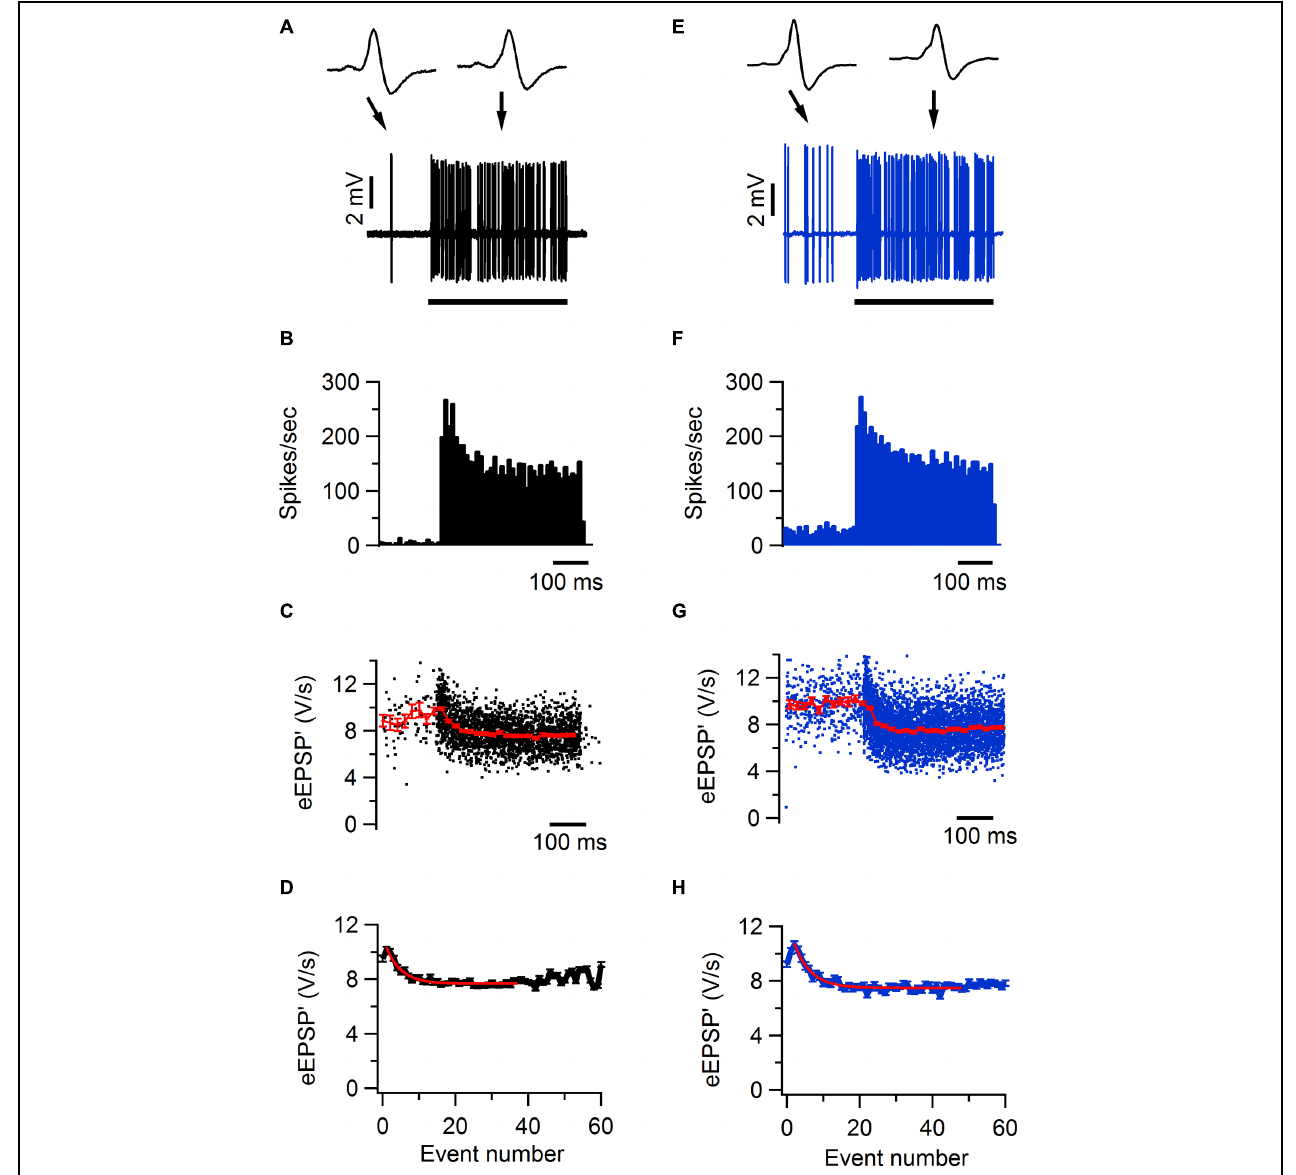
FIGURE 4 | Sound-evoked STD in Tsc1 + / − and wild-type mouse. (A) Increase in firing frequency during a 400 ms, 80 dB noise burst in a juxtacellular recording from a wild-type mouse. Insets show two juxtacellular complex waveforms before and during sound stimulation, respectively. Black bar indicates the presentation of the sound stimulus. (B) Peristimulus time histogram showing primary-like response to sound. (C) Maximal amplitude of the first derivative of the eEPSP